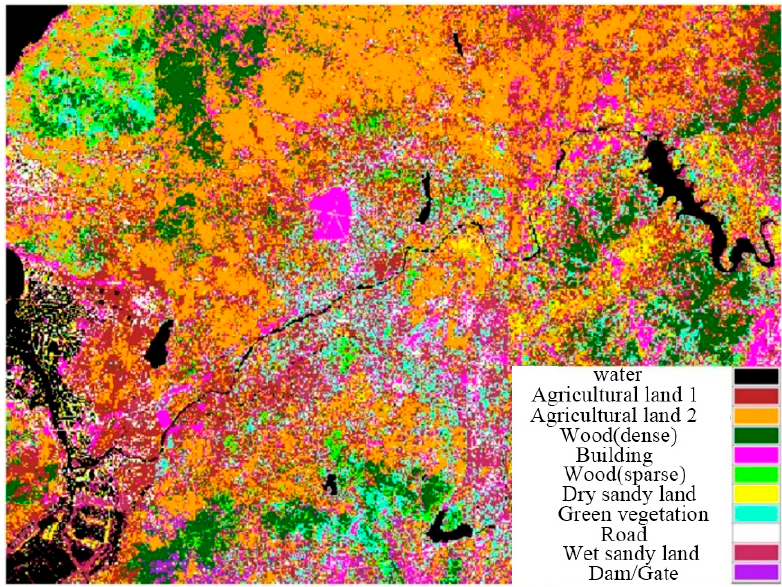
Figure 2. Remote sensing image of the study area.